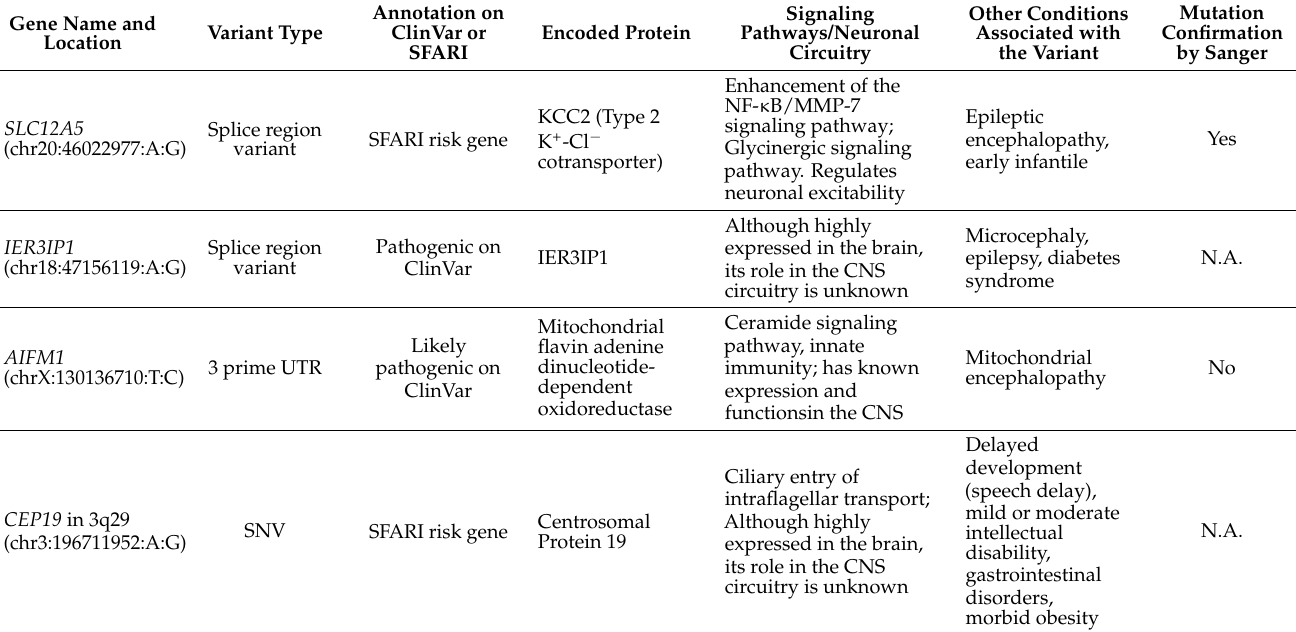
Table 3. Summary of all variants and results of Sanger sequencing in one participant (subject